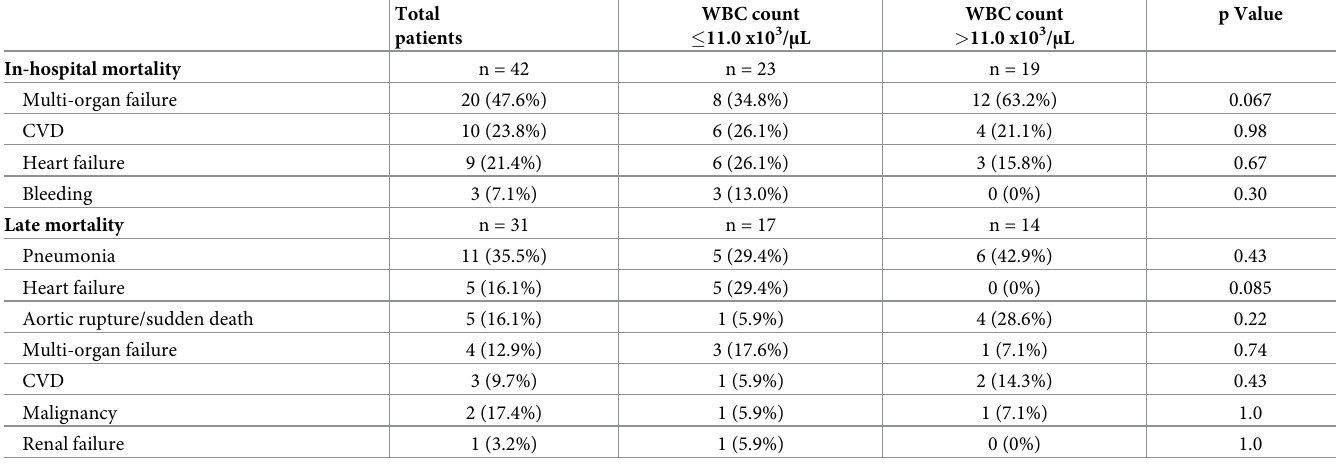
Table 5. Mortality and its causes in the total patients and per white blood cell count ( < 11.0 x10 3 / μ L vs. > 11.0 x10 3 / μ L).